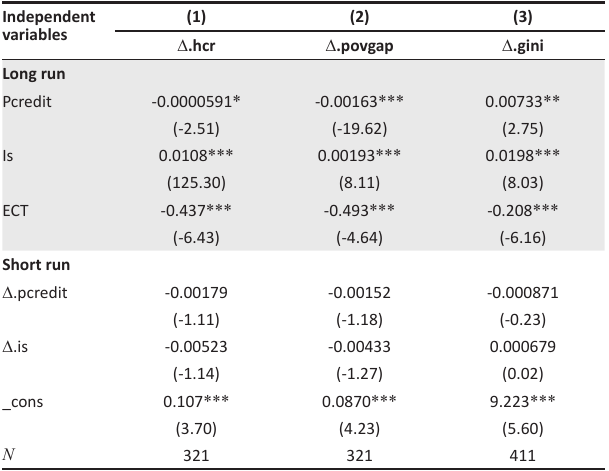
TABLE 1: Summary of the pooled mean group on the cointegrating and causality relationship between poverty proxies and financial intermediation and financial